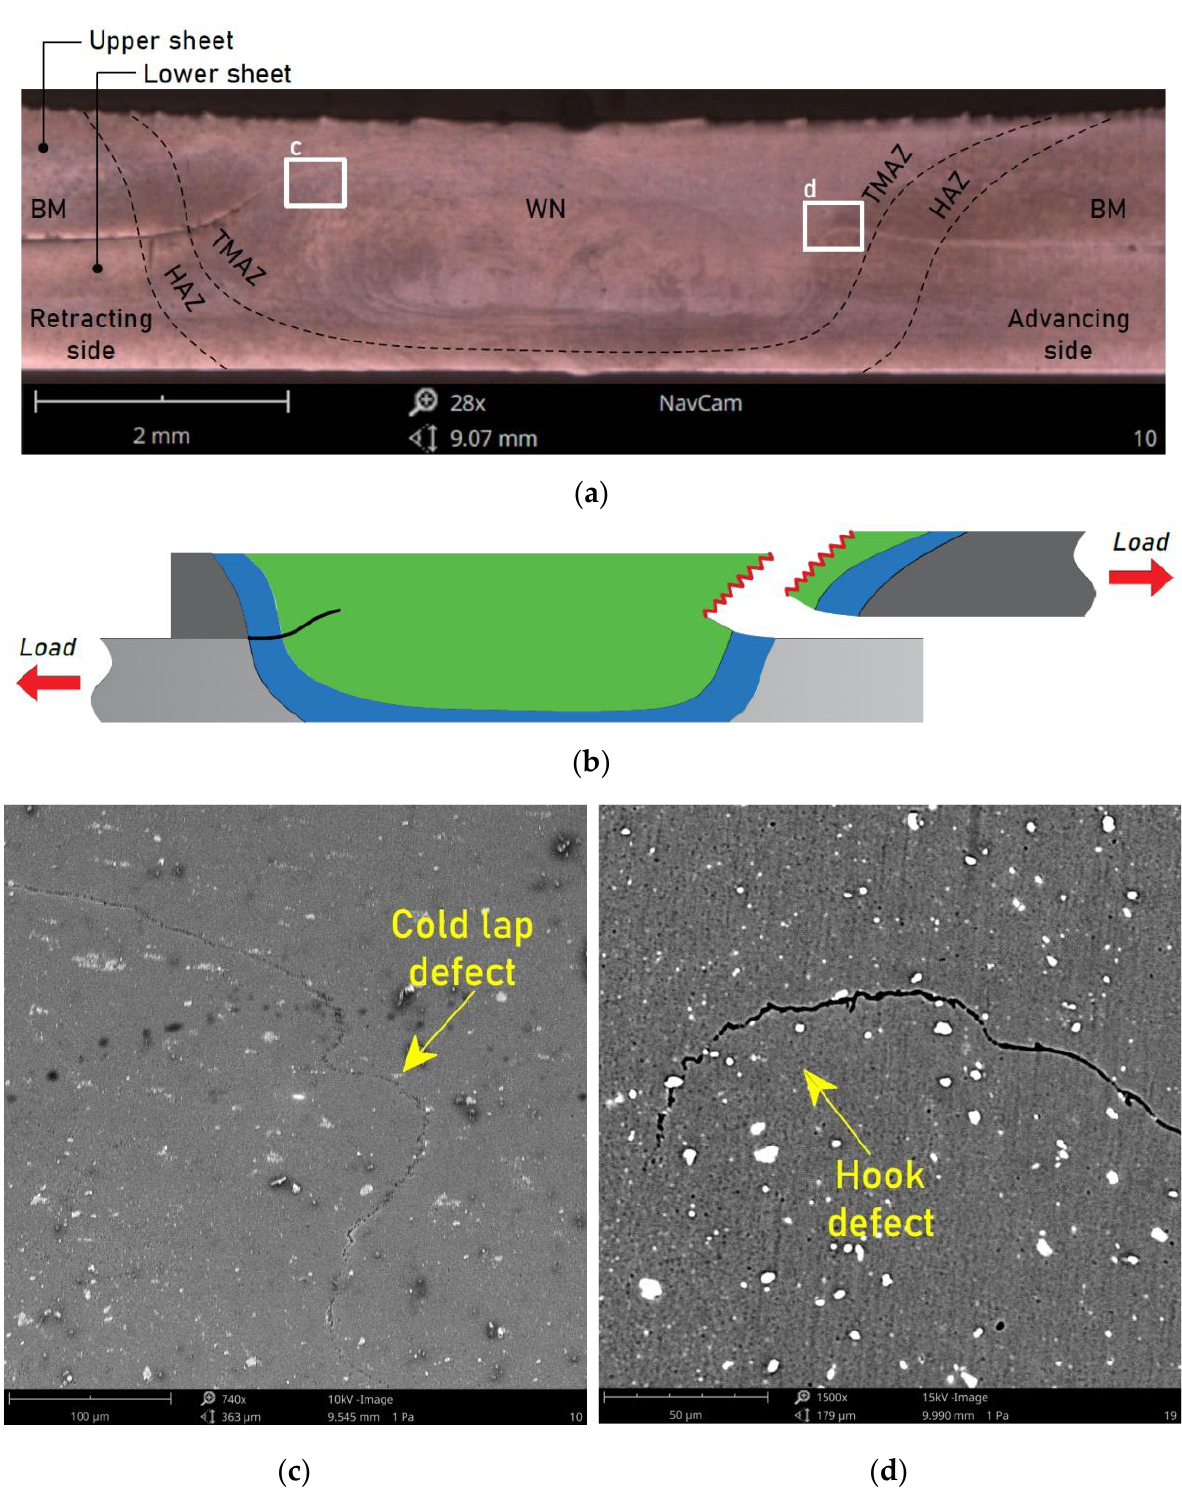
Figure 7. ( a ) Cross-sectional view of the FSW sample, ( b ) failure mode, and ( c , d ) magnification of the areas c and d, respectively, for a weld made with the parameters d = 1.9 mm, f = 400 mm/min, and n = 800 rpm.